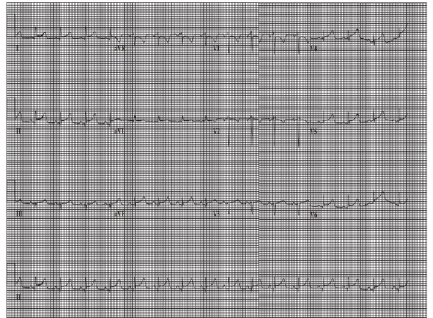
Figure 1: EKG on admission.